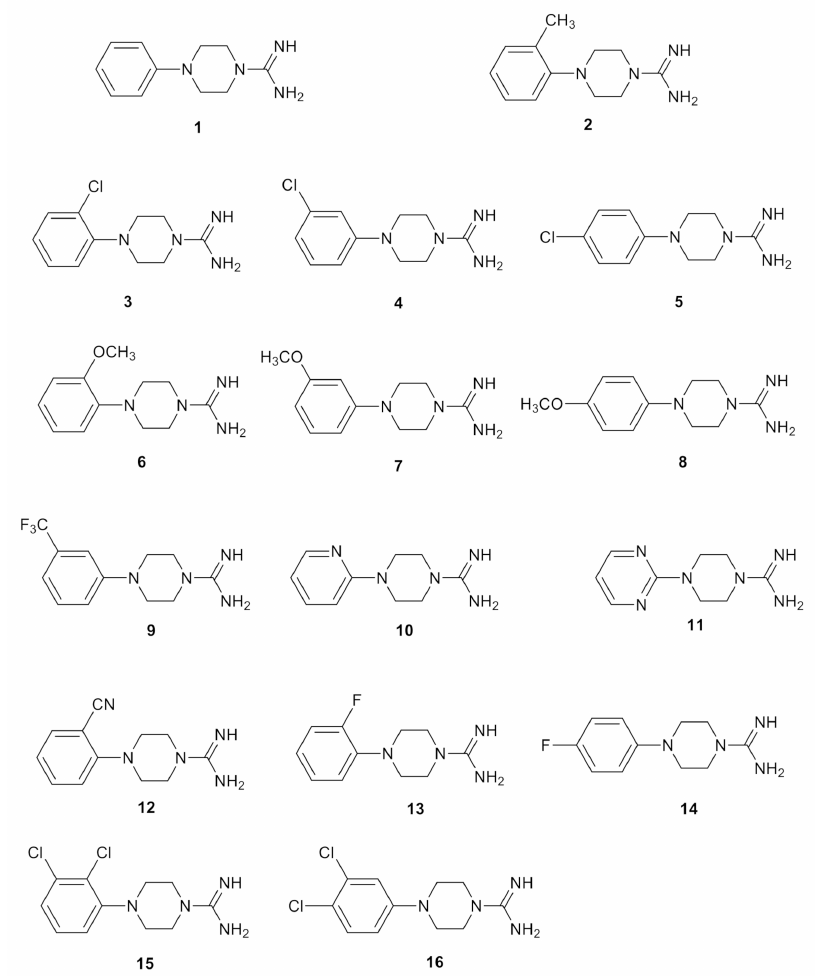
Figure 3. Chemical structures of the investigated h TAAR1